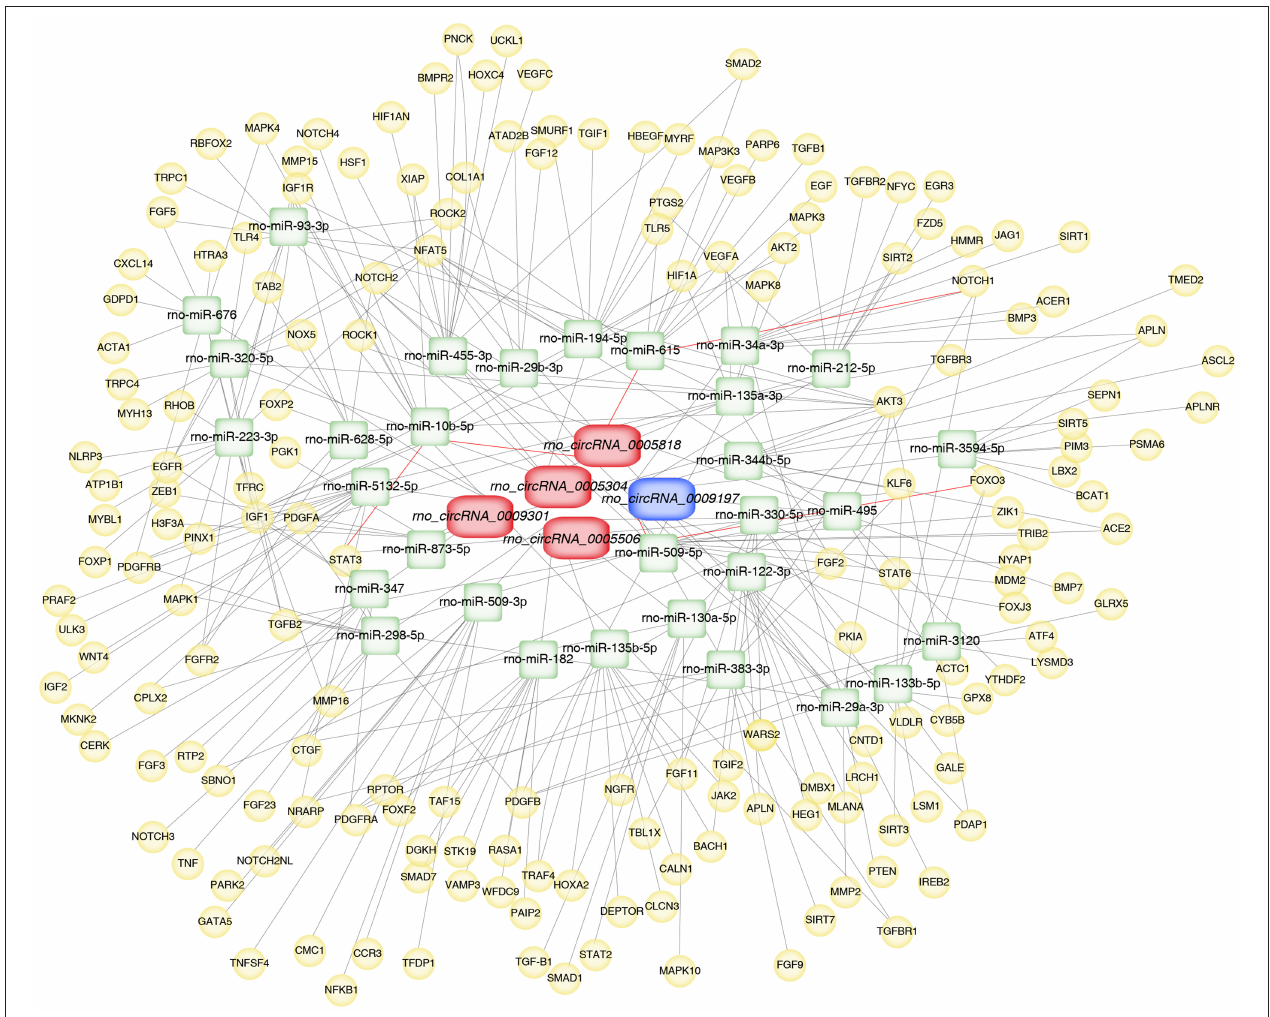
FIGURE 5 | Construction of circRNA-miRNA-mRNA network in aortic vascular tissues of rats. The red color and blue color represent upregulated and downregulated significant DE circRNAs, respectively. Green color represents miRNAs, yellow color represents mRNAs. Red bold lines represent three promising circRNA-miRNA-mRNA regulatory axes were selected in hypertensive rat aorta, including rno_circRNA_0005818/miR-615/NOTCH1, rno_circRNA_0009197/miR-509-5p/FOXO3 and rno_circRNA_0005818/miR-10b-5p/STAT3, respectively. circRNAs, circular RNAs; miRNA, microRNA; mRNA, messenger RNAs; DE, differentially